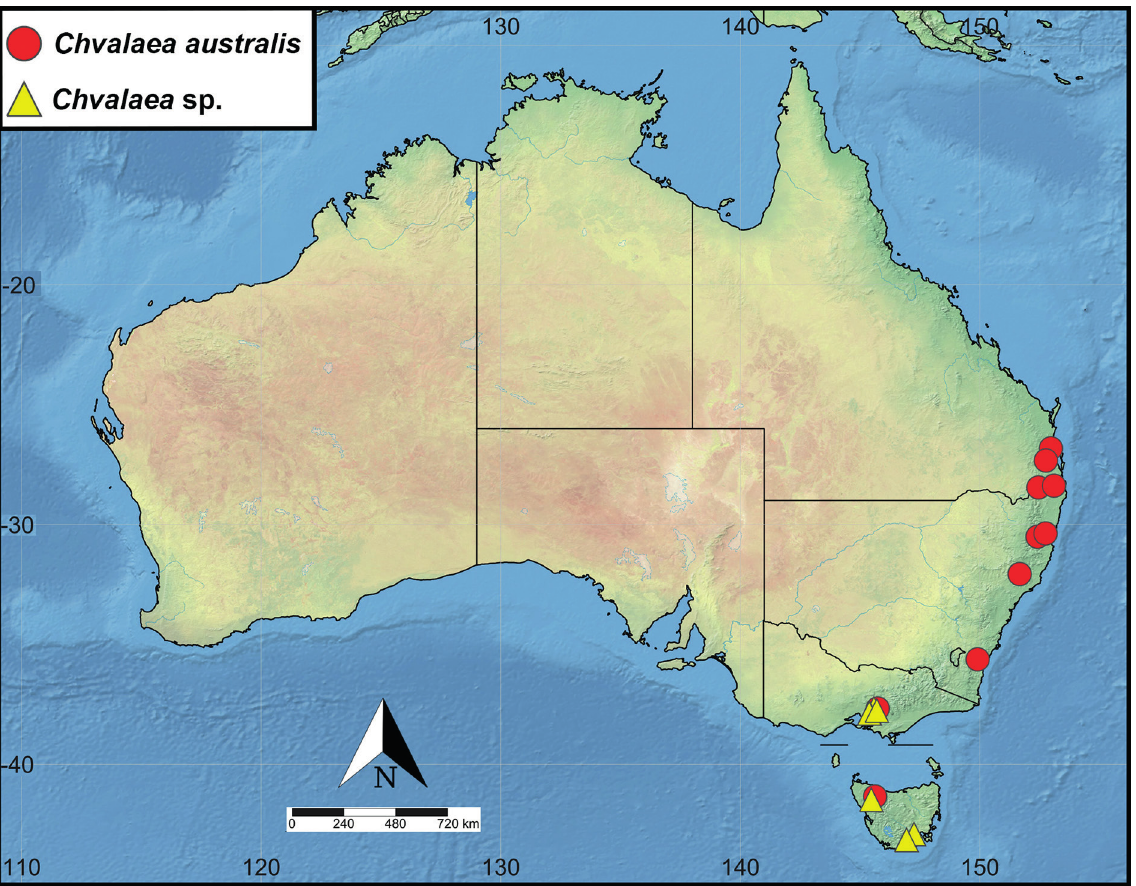
Fig. 4. Geographical records of the Australian species of Chvalaea Papp & Földvári,